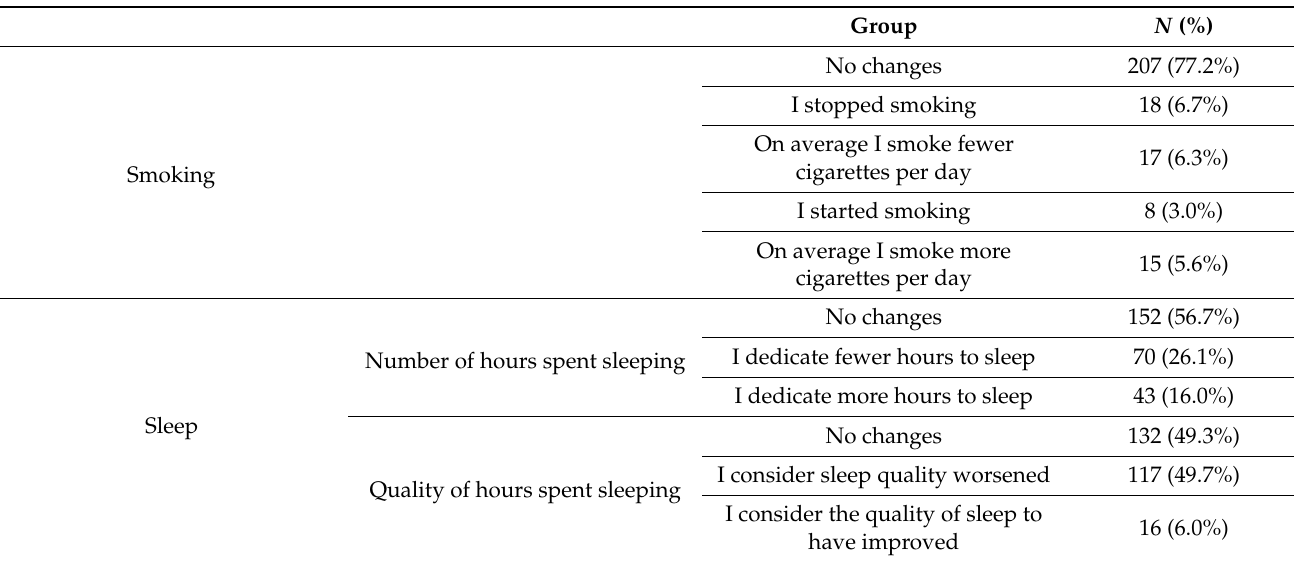
Table 1. Descriptive statistics of the lifestyle changes of the sample ( n =